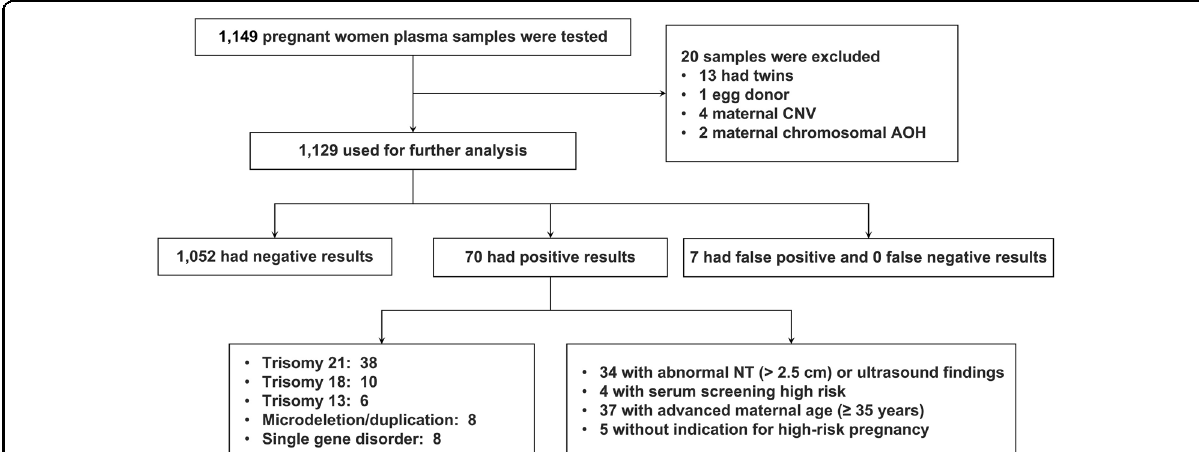
Fig. 6 Clinical validation for multiple types of genetic disorders using pregnant women ’ s plasma samples. A total of 1149 samples collected from pregnant women ’ s blood were tested. Among them, 20 samples were excluded due to analytical interferences including 13 dizygotic twin pregnancies, one twin pregnancy through egg donor, four with maternal CNV ( ≥ 3 Mb), and two with maternal AOH which also failed RD analysis quality control. Next, 1129 samples were subjected to further analysis, and 70 positive cases were identi fi ed through the new NIPS method, including 54 aneuploidies, eight MMS and eight cases with monogenic disorders. Clinical information and prenatal fi ndings were collected and shown for 70 positive